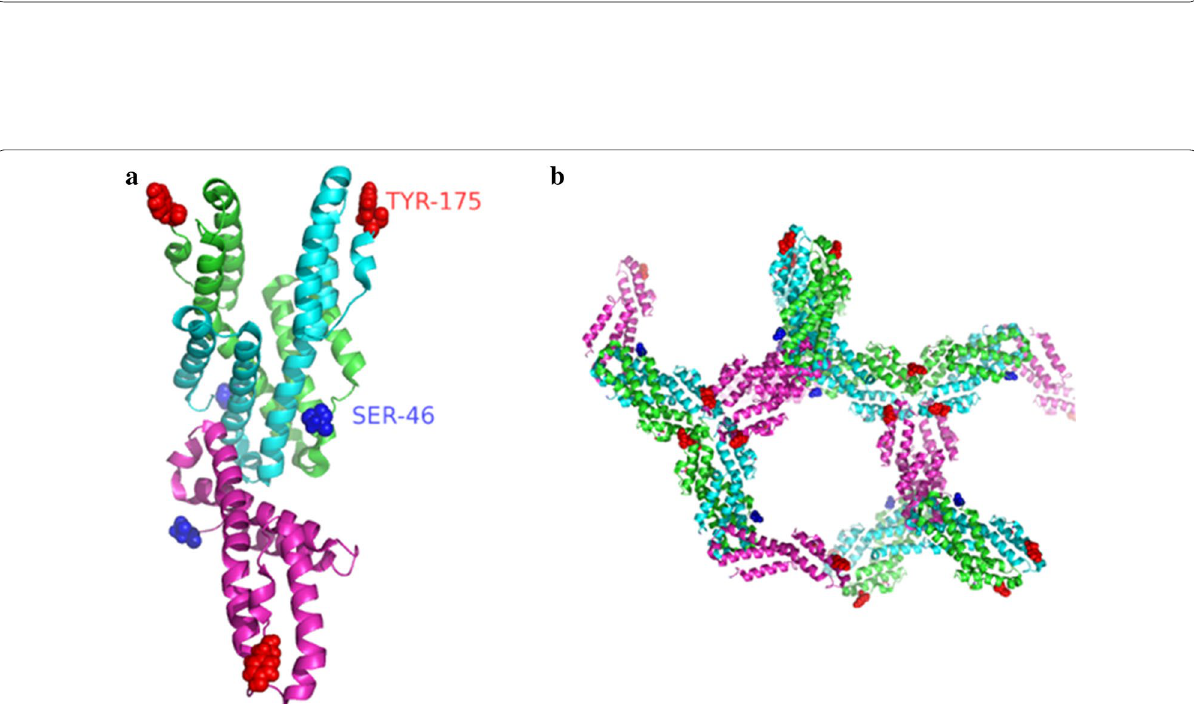
Fig. 4 Size-exclusion chromatography. a Calibration curve using calibration standards: blue dextran (2 kDa), bovine serum albumin (66 kDa), carbonic anhydrase (29 kDa), and cytochrome- c (12.4 kDa). b N- Pf CelTOS is shown in blue dash, CH- Pf CelTOS is shown in green and a histidine tag-free version of CH- Pf CelTOS is shown in red dash. Calibration standards are overlaid and shown in black